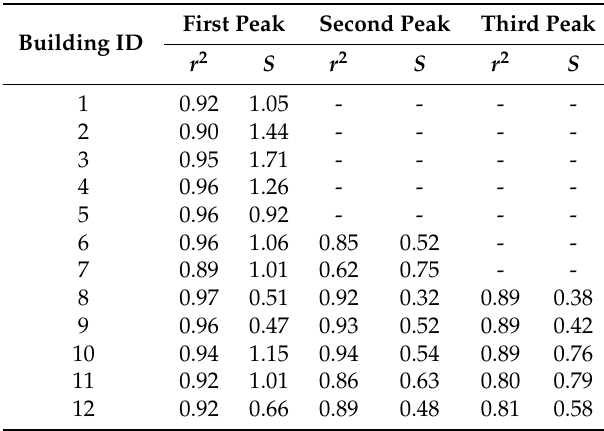
Figure 6. Triple Heating Cycle peaks. Table 1. Peak detection r 2 and S